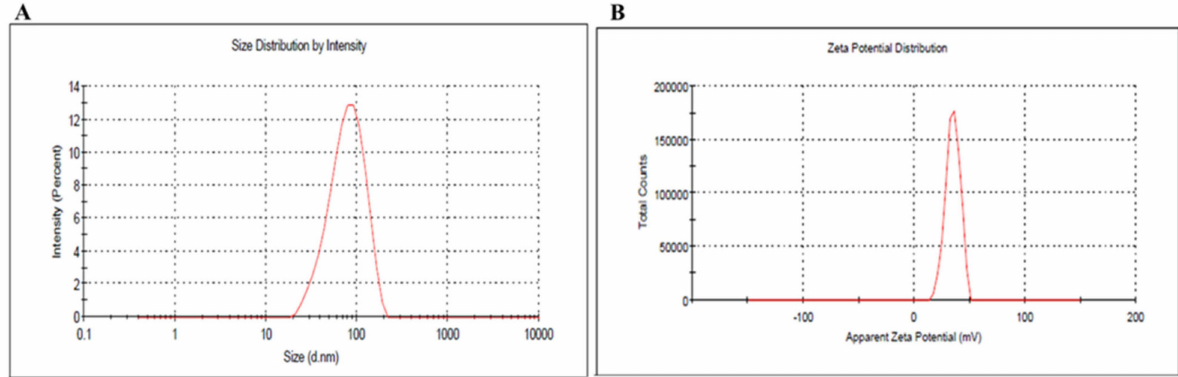
Figure 2. ( A ) Particle size and size distribution (PDI), and ( B ) zeta potential of the developed